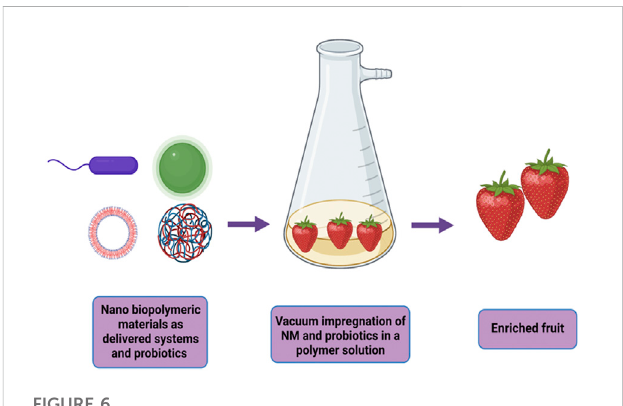
FIGURE 6 Vacuum impregnation of nano-delivery systems and probiotics with atmospheric